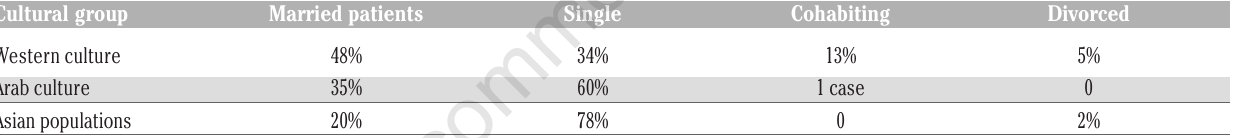
2. Marital status of thalassaemia patients across